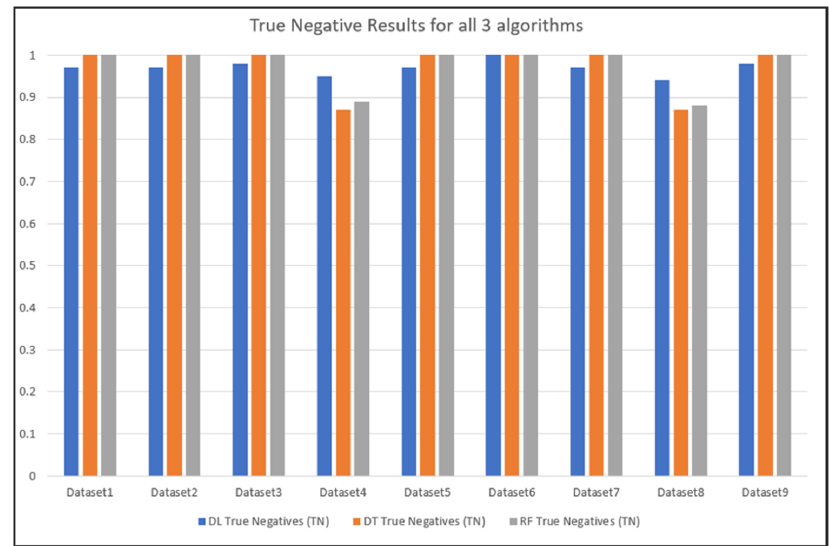
Figure 6. Comparison of the benign prediction results for all three ML algorithms.